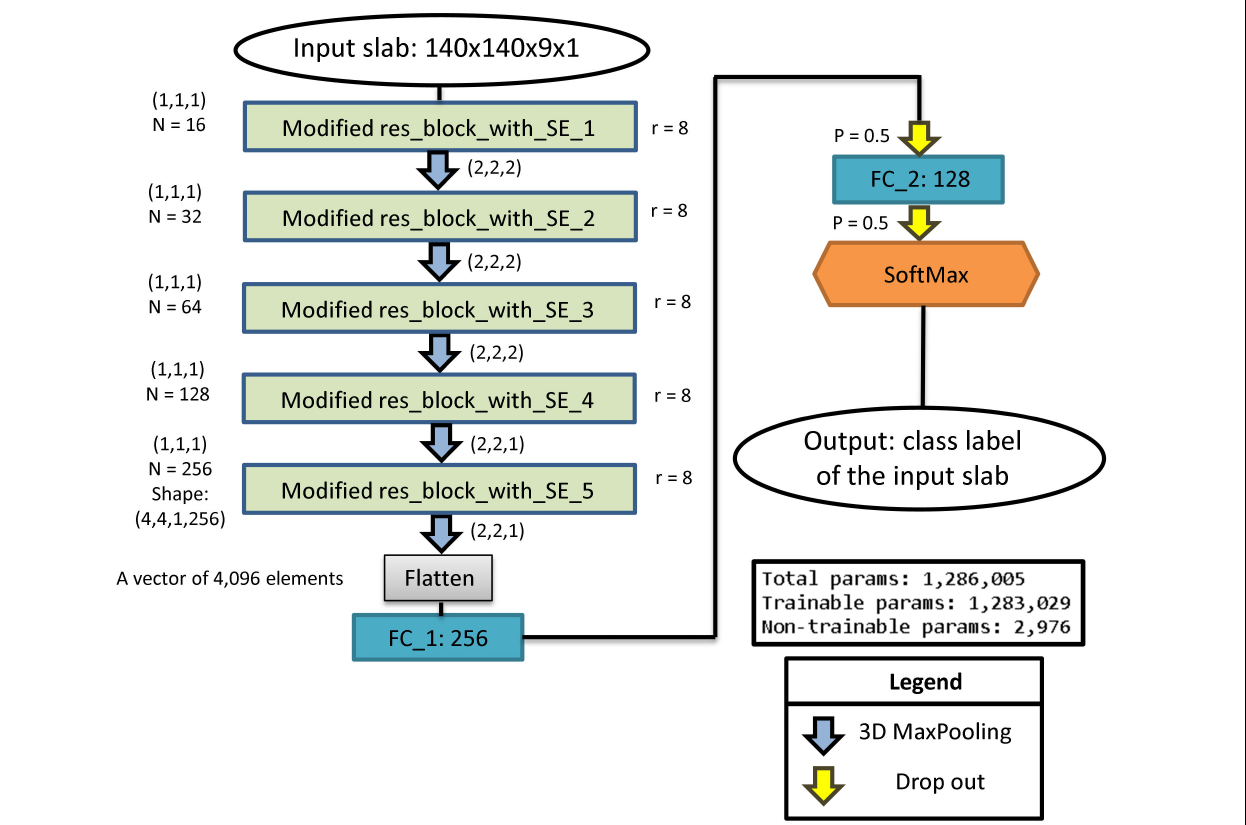
FIGURE 3 | The architecture of the residual SE-CNN slab-level artifact classifier.